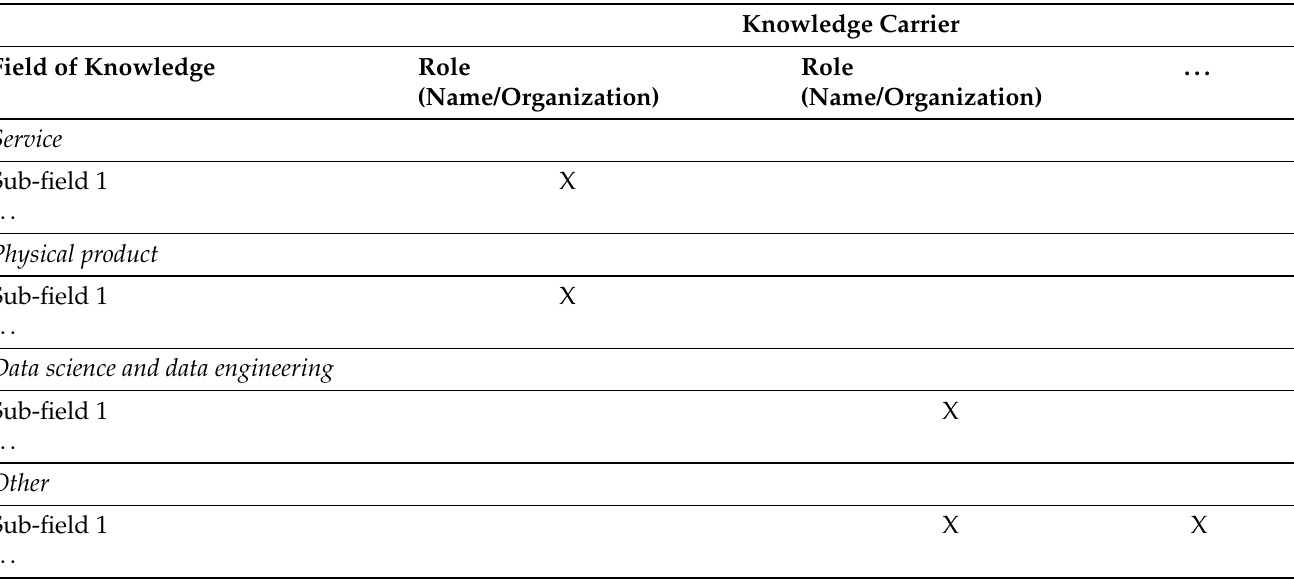
Table 2. Knowledge carrier